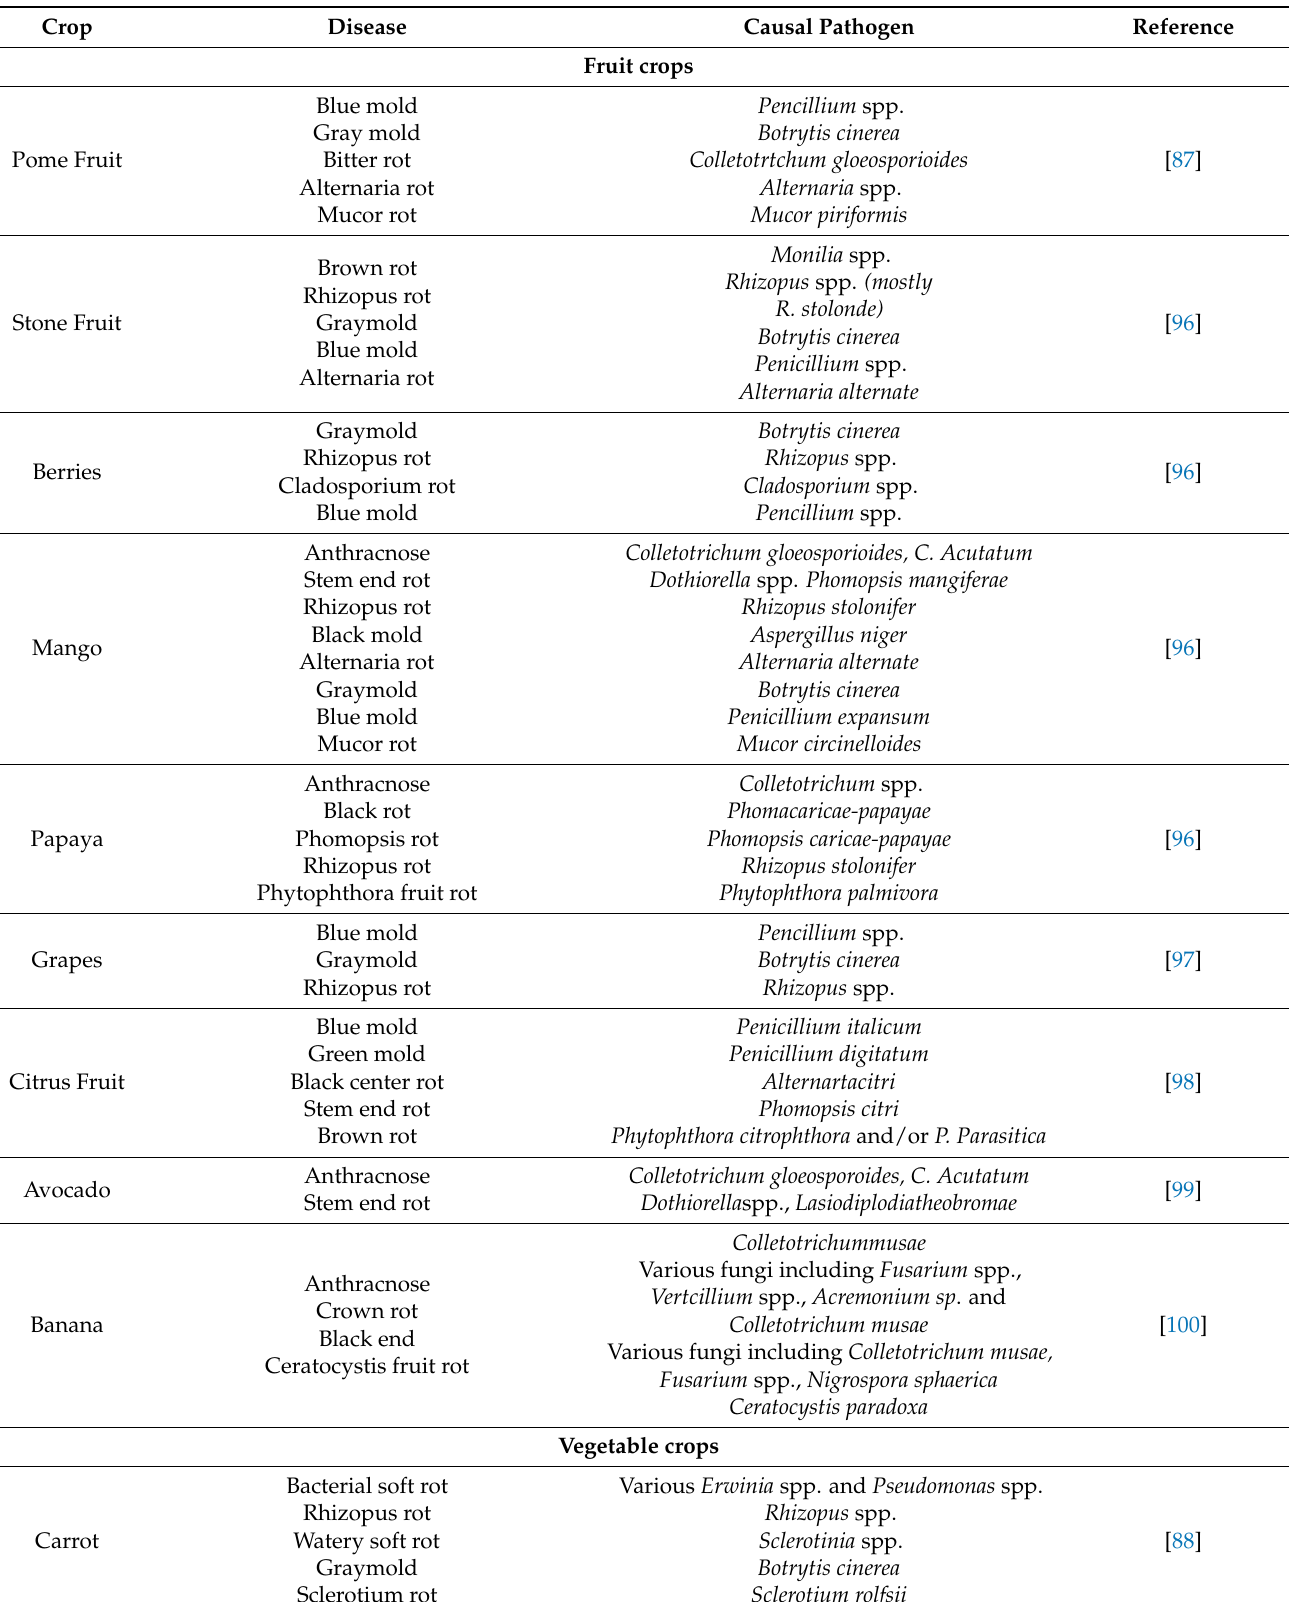
Table 2. Major pathogens causing the post-harvest losses in important fruit and vegetable